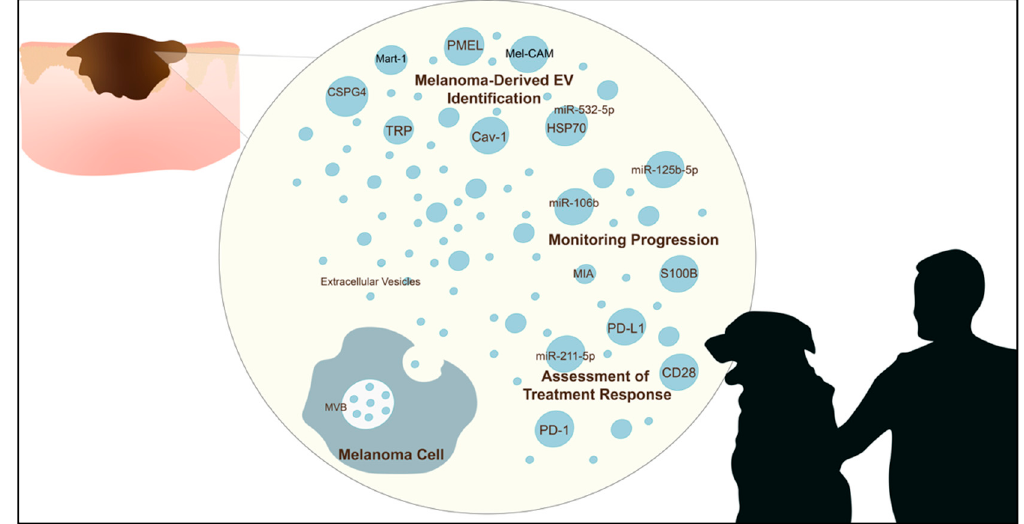
Figure 1. Potential markers of melanoma-derived extracellular vesicles (EVs) that may play a role in diagnosis, monitoring progression, and treatment response in humans and other mammals.